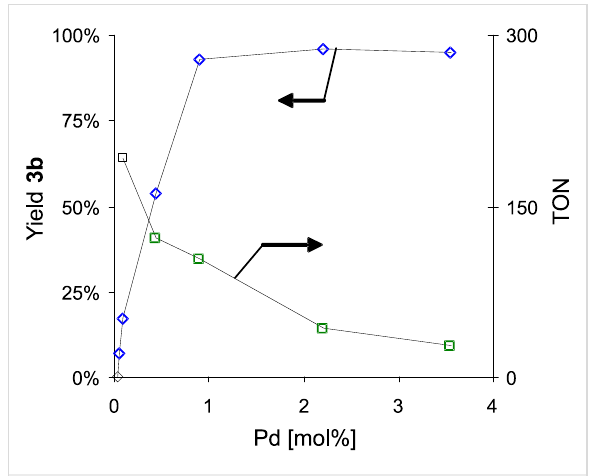
Figure 3: Influence of Pd(OAc) 2 concentration on the results of the Suzuki–Miyaura reaction of phenylboronic acid ( 1 ; 124 mol %) with p -bromotoluene ( 2b ; 5 mmol) assisted by SRS1a-40 [5 g: cf. Table 2; ball milling: 2 agate milling beakers ( V = 45 ml), 7 agate milling balls ( d = 15 mm) per beaker, 800 rpm, 10 min].